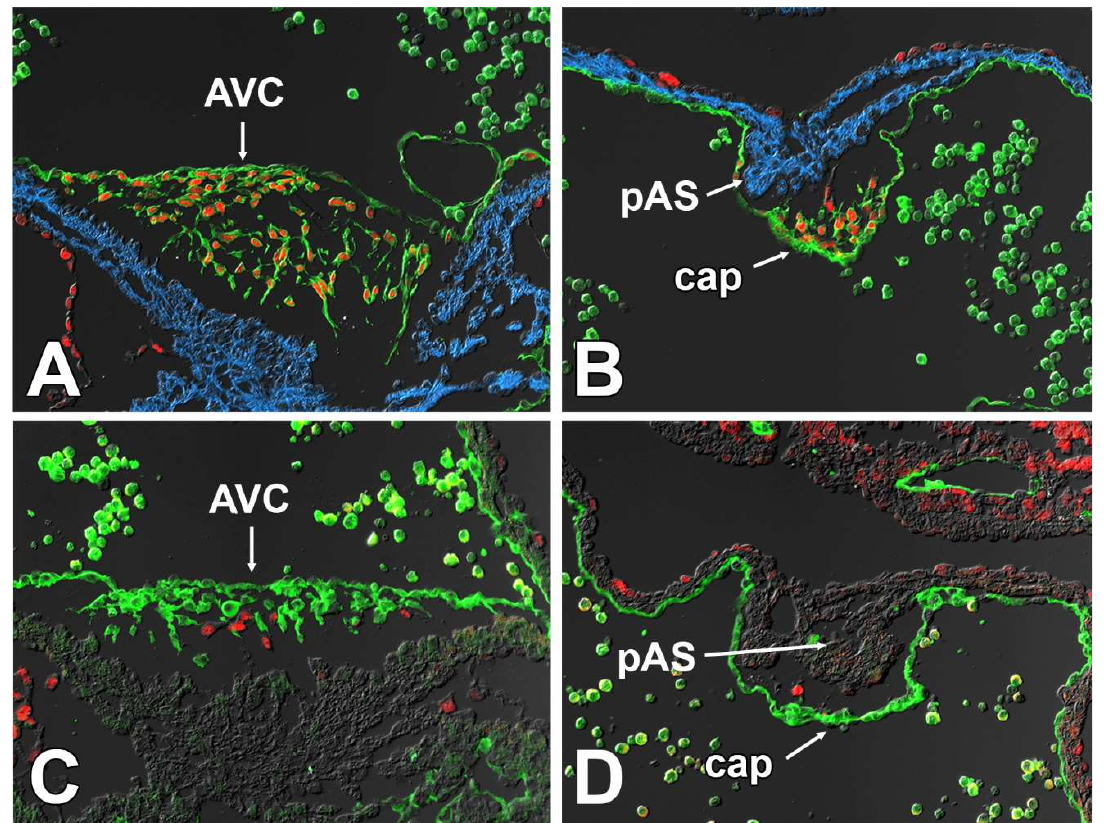
Figure 11. Sox9 expression in the endocardial lineage is critically important for the development of the AV cushions and the mesenchymal cap. Panels ( A , B ) show the expression of Sox9 in endocardially derived cells in a control Tie2cre;R26mG specimen at ED10.5 whereas panels ( C , D ) show a Tie2cre;Sox9fl/fl;R26mG littermate. Note the absence of Sox9 in the GFPpositive endocardially derived mesenchyme in the hypoplastic AV cushion in ( C ) and the hypoplastic cap in ( D ). AVC = AV cushion, CAP = mesenchymal cap, pAS = primary atrial septum.